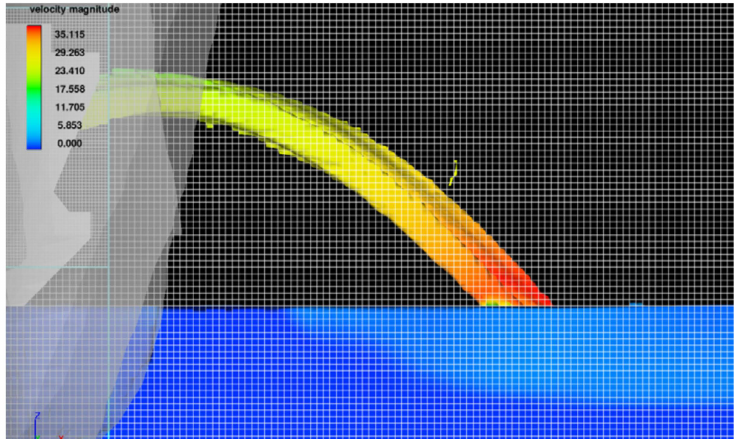
Figure 10. Mesh size of the half-height outlet